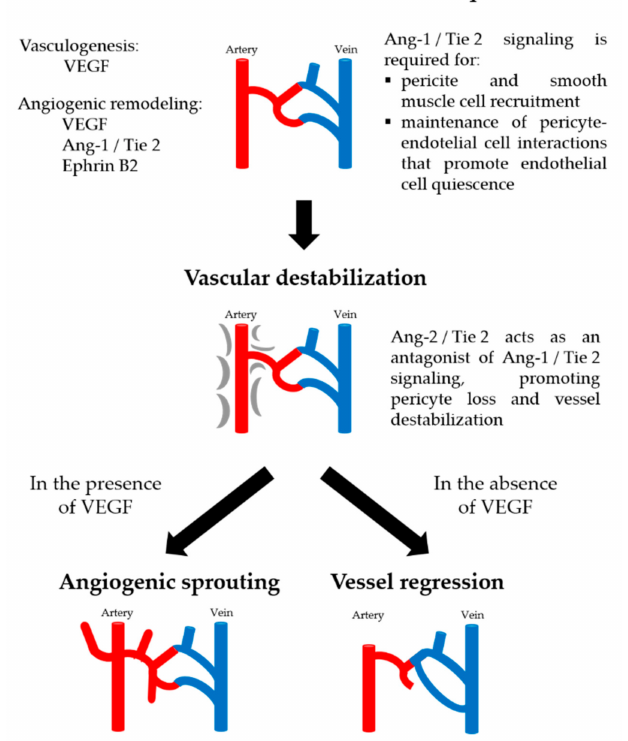
Figure 1. Vascular remodeling processes. Remodeling of the primary vessel is directed by VEGF, Ang- 1, and Ephrin-B2 signaling pathways. Angiogenesis is characterized by endothelial cell activation and angiogenic sprouting, which require Ang-2-mediated vascular destabilization. In the presence of VEGF, this will lead to angiogenic sprouting, and, in the absence of VEGF, it will lead to vessel